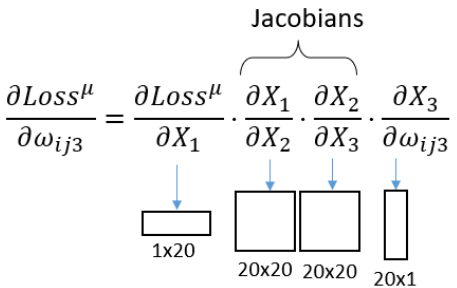
Figure 5. Jacobians and their sizes, taking the network from the third layer.